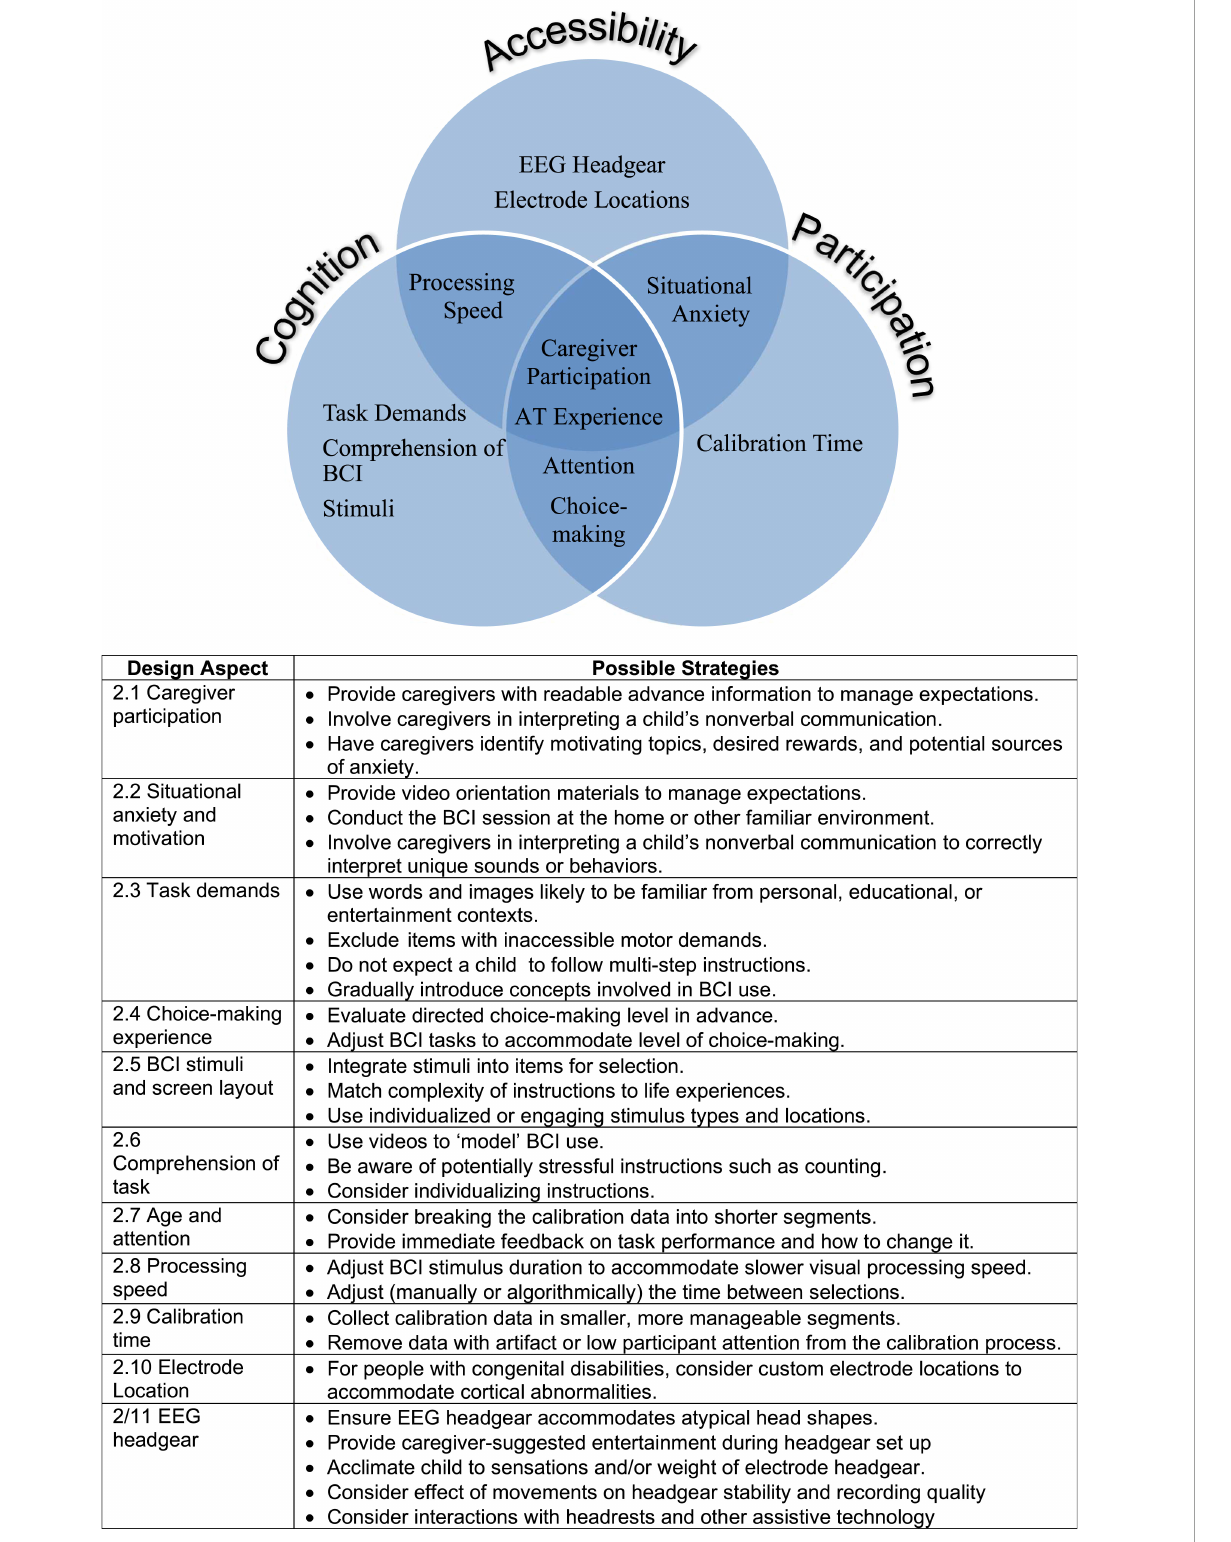
FIGURE2 Concept map, design aspects, and possible strategies to consider in brain-computer interfaces (BCI) design for children with